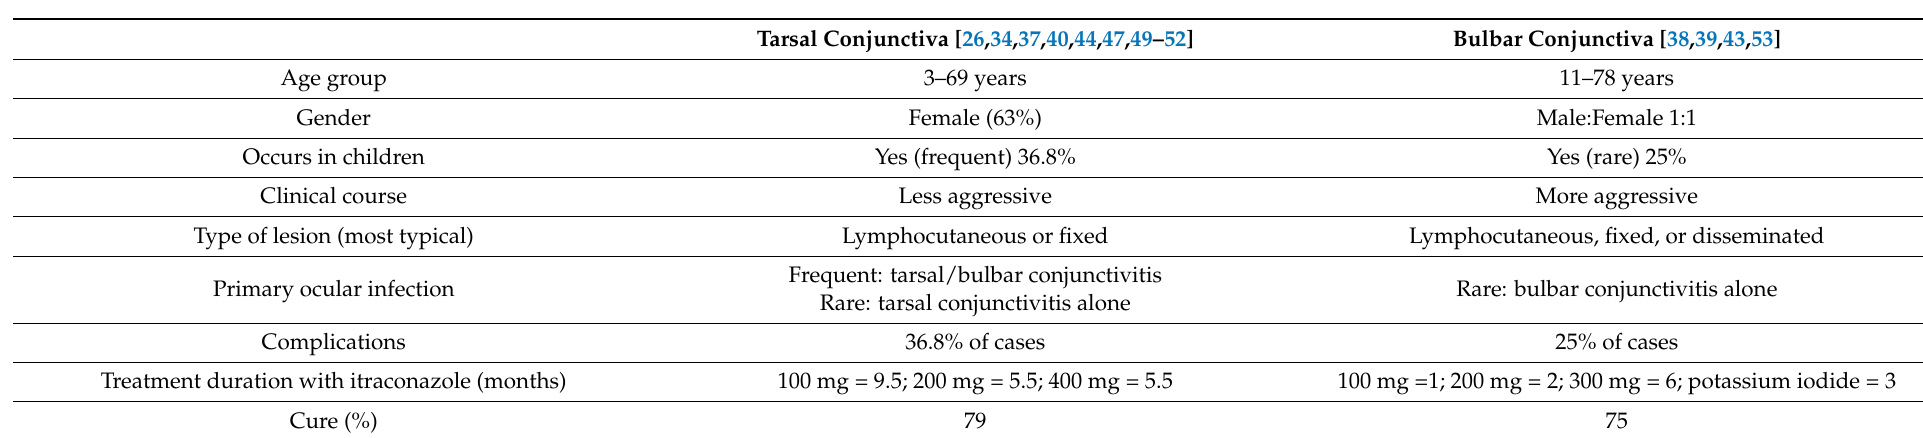
Table 4. Consolidated of the clinical-epidemiological findings of conjunctival